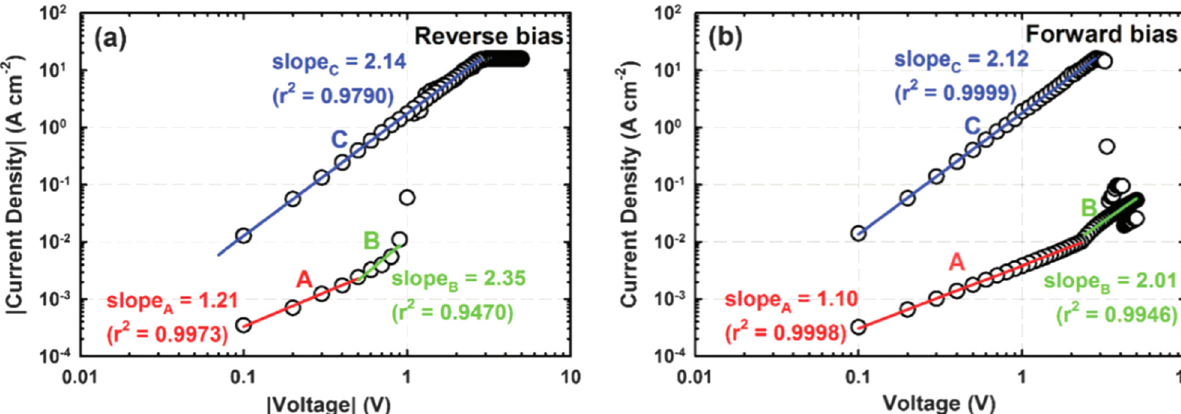
Figure 11: Full logarithmic current density – voltage ( J – V ) relationships of the Aloe vera - based memory device in the ( a ) reverse - bias and ( b ) forward - bias regions. Experimental data are represented by open symbols. Linear fi ttings to the experimental data are represented by solid lines [ 81 ] . Reproduced by permission of the PCCP Owner